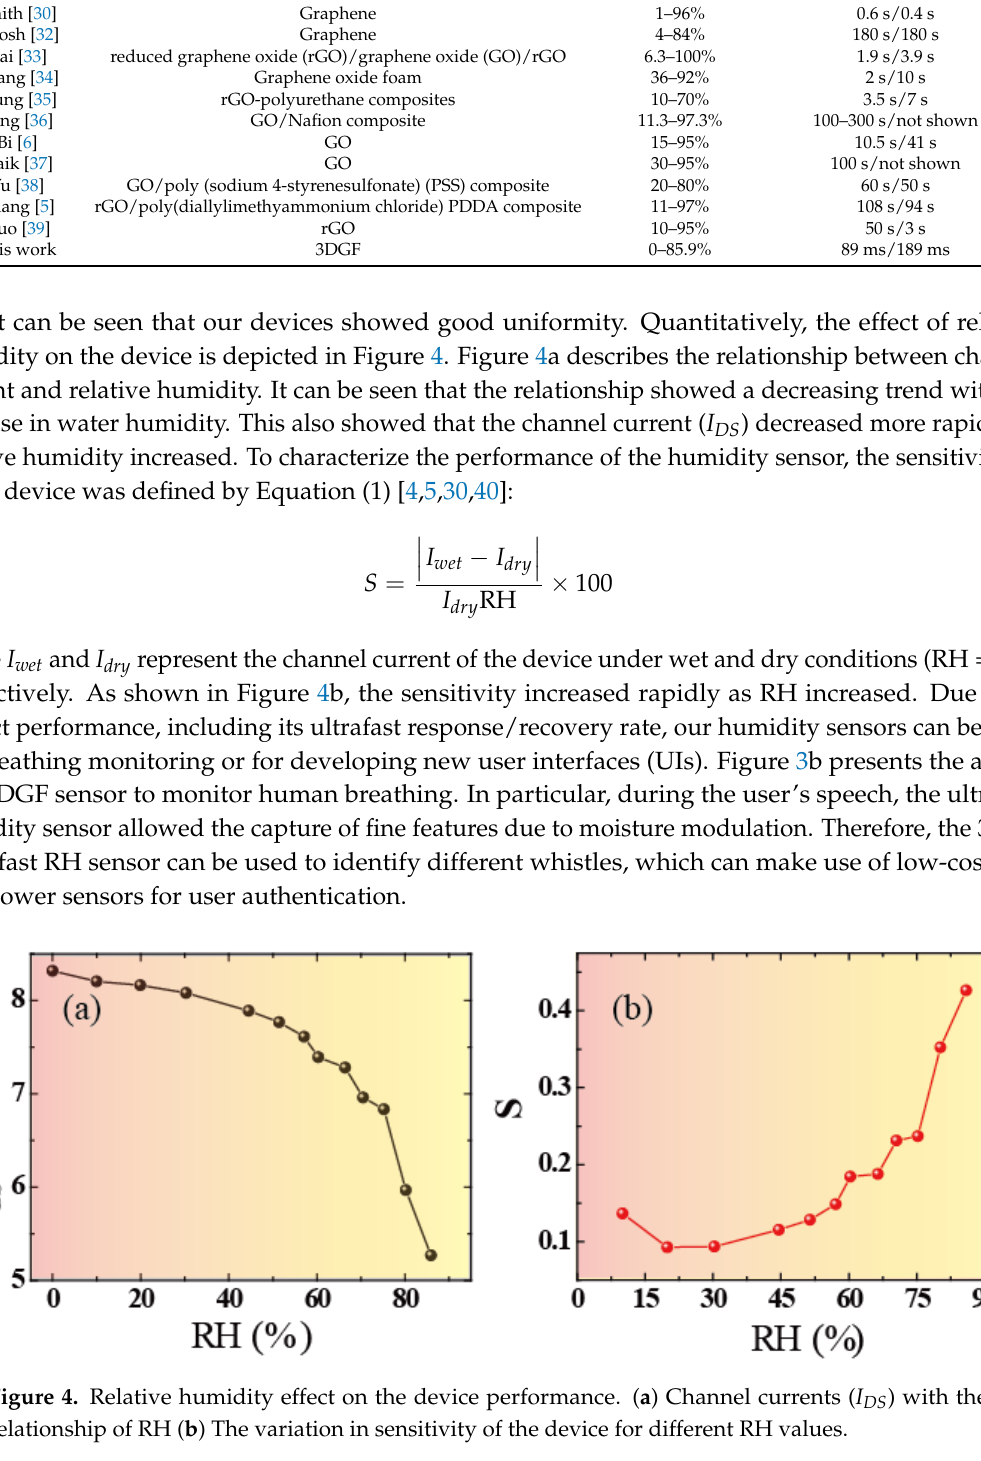
Table 1. Comparison of different reported humidity sensors with graphene series materials.